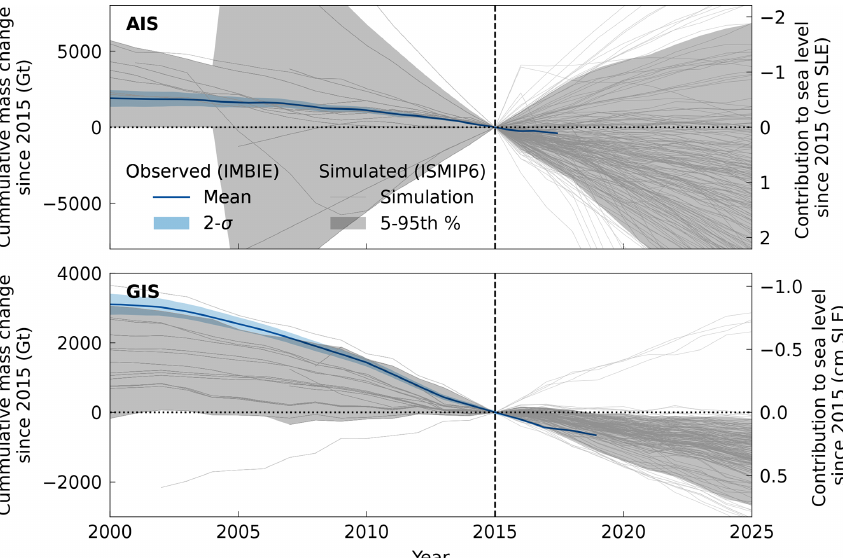
Figure 1. Observed and simulated historical mass changes from the Antarctic ice sheet (AIS) and Greenland ice sheet (GIS) between 2000 and 2020 in gigatons (Gt) and centimeters of sea level equivalent (cmSLE). A consensus estimate of observed mass changes (The IMBIE team, 2018; The IMBIE Team, 2019) is plotted in blue along with their respective uncertainties (shaded). The ensembles of ISMIP6 (Goelzer et al., 2020; Seroussi et al., 2020) historical simulations and projections are plotted with dark-gray lines, and the 5th to 95th percentile mass loss rates are shown as a 90% credibility interval with light-gray shading. Due to the large variance in ISMIP6 historical simulations for Antarctica, the uncertainties in IMBIE are not visible in the